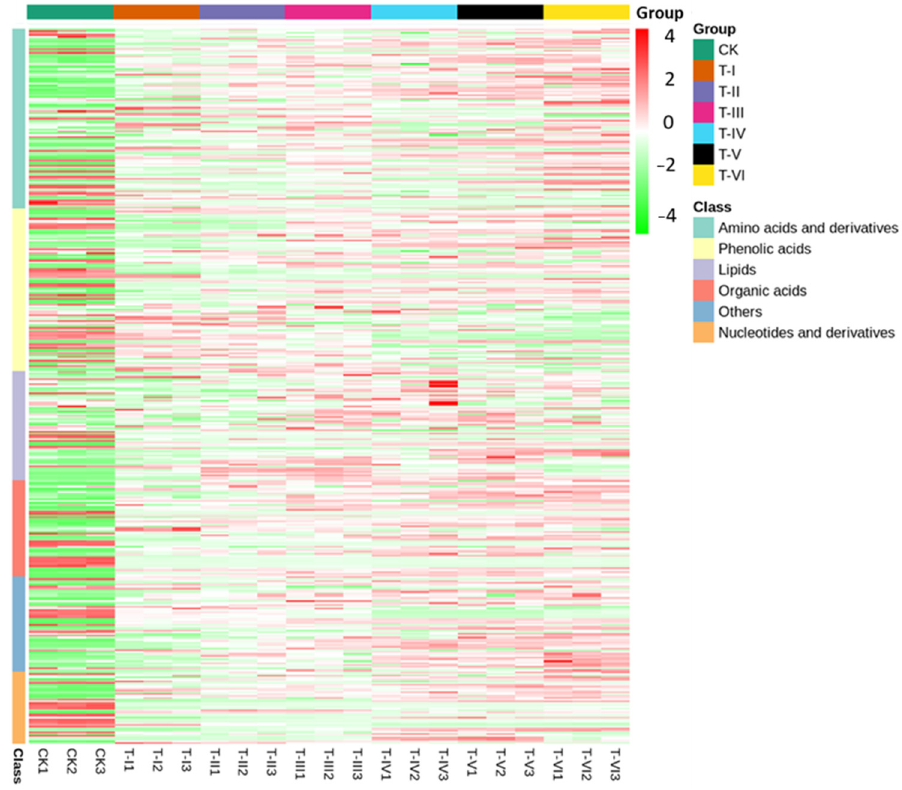
Figure 6. A heatmap graph showing clusters of metabolic compounds in different samples (Sample codes indicate the samples fermented for 0 d (CK), 5 d (T-I), 10 d (T-II), 15 d (T-III), 20 d (T-IV), 25 d (T-V), and 30 d (T-VI).